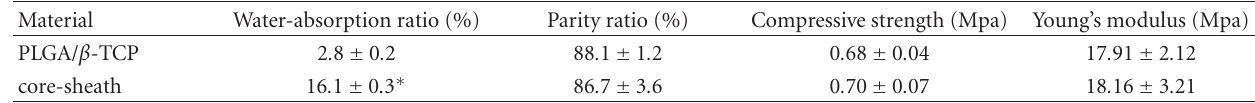
Table 1: Water-absorption ratio, pority ratio, and mechanical strength of the PLGA/ β -TCP sca ff olds and the core-sheath structure composite sca ff